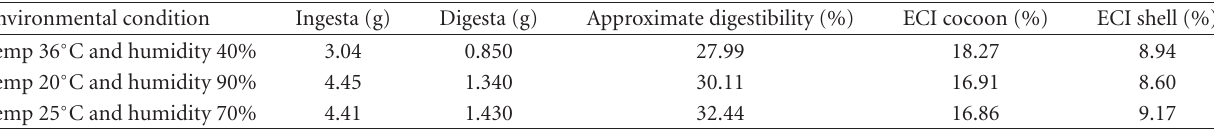
Table 4: E ff ect of di ff erent temperature and humidity conditions on nutritional indices of